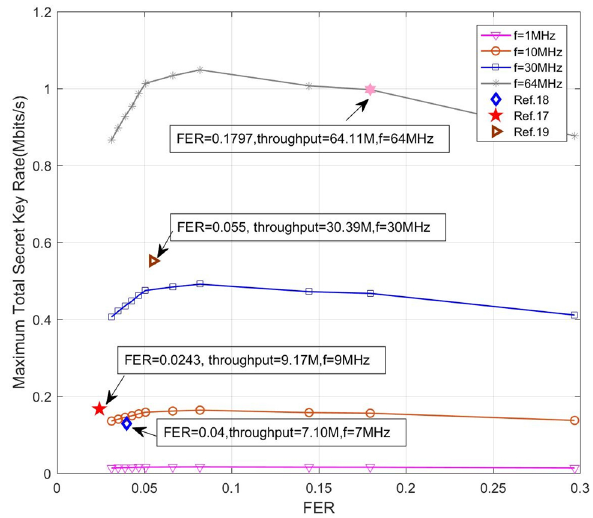
Figure 7. The maximum total secret key rate vs FER curves of the proposed layered decoder with different repetition rates (Four points correspond to FERs and throughputs listed in Table